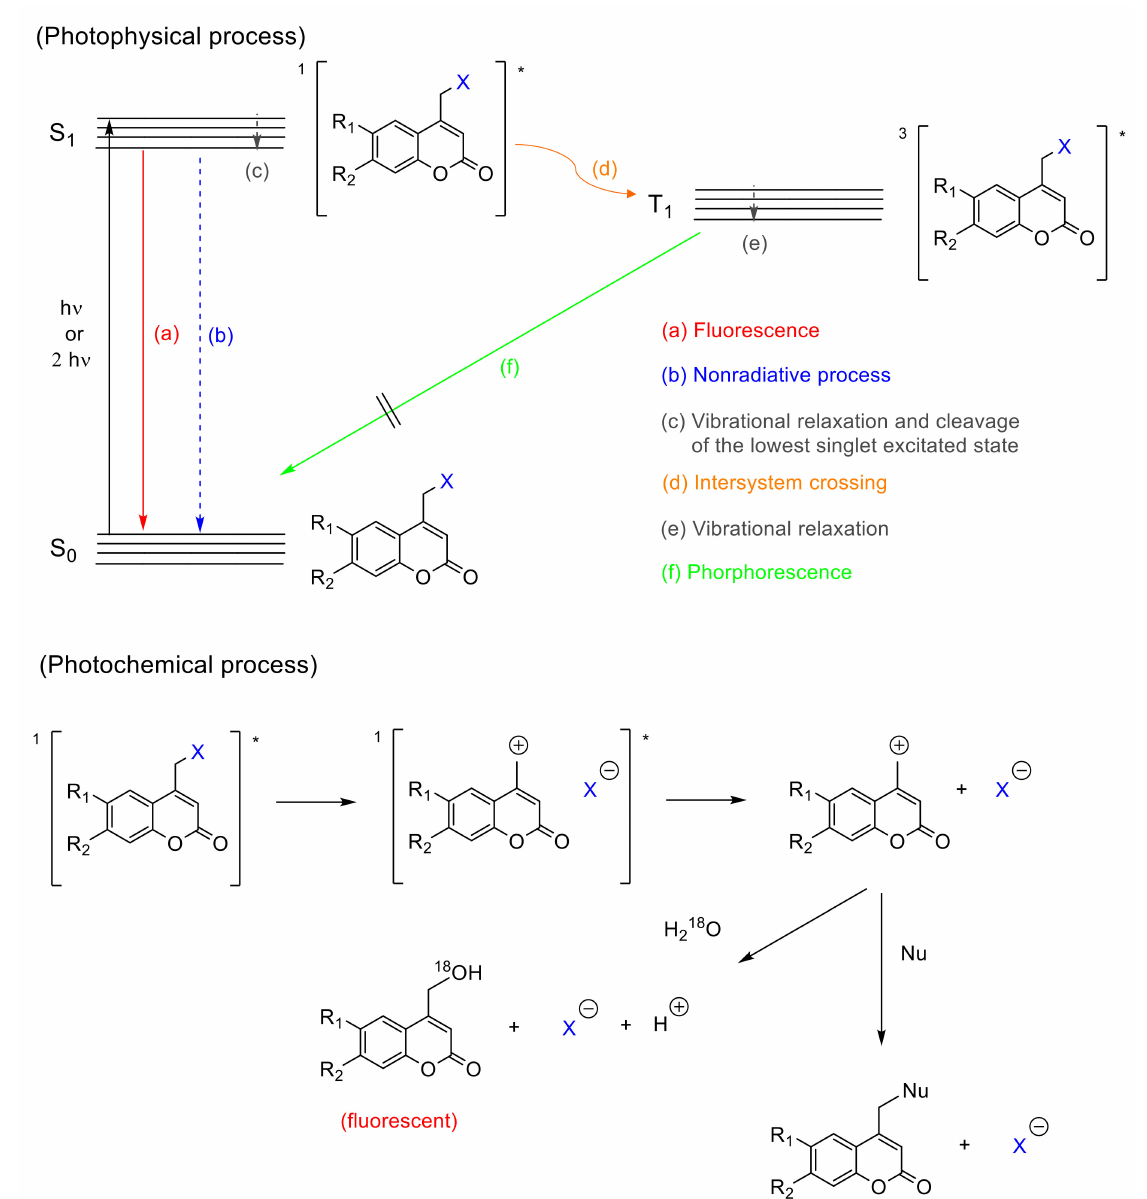
Figure 6. Mechanism of the photocleavage reaction of coumarin derivatives. The asterisk (*) denotes the excited state of the